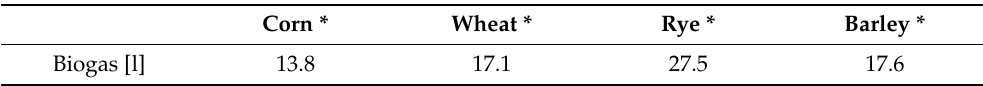
Table 2. Biogas production in small-scale testing rig. Corn * Wheat * Rye * Barley * Biogas [l] 13.8 17.1 27.5